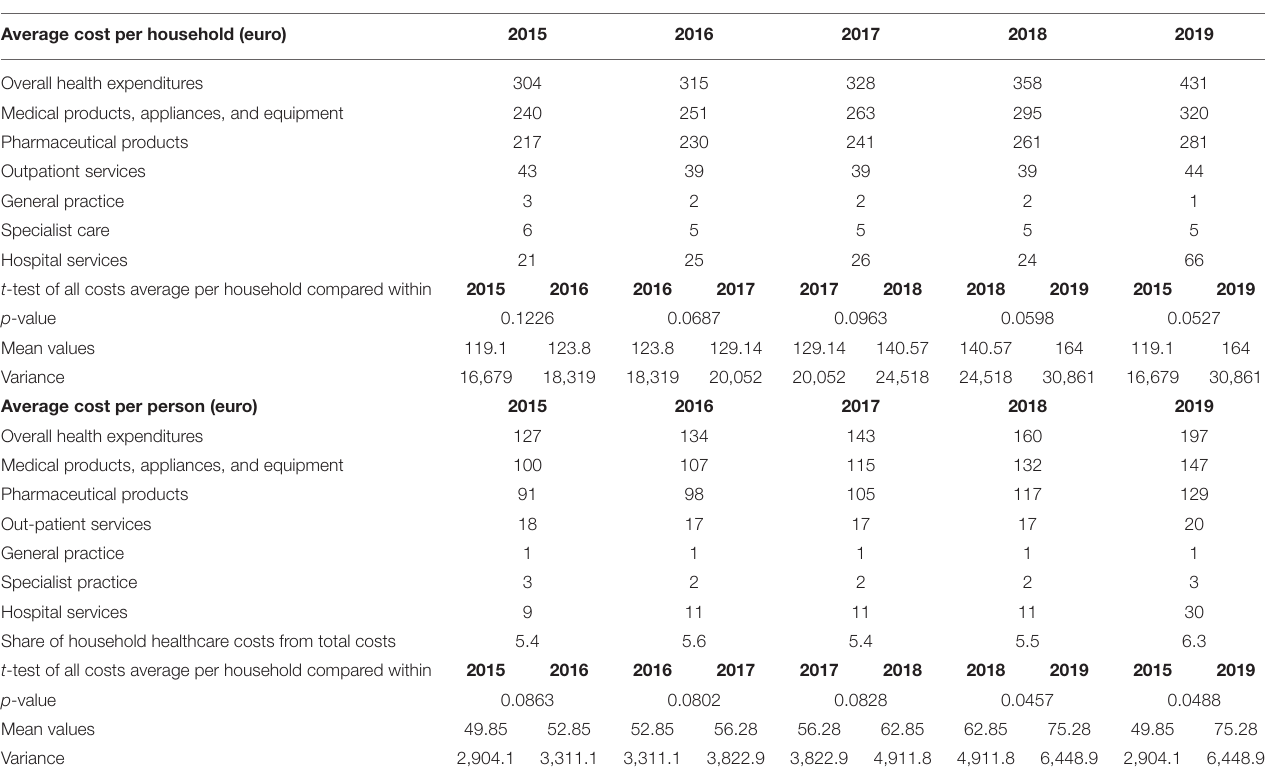
TABLE 4 | The average household cost and cost per